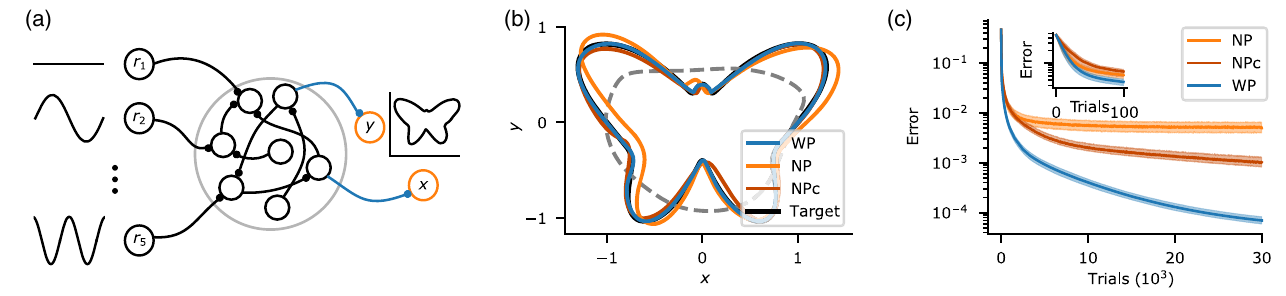
FIG. 7. WP outperforms NP on a reservoir computing-based drawing task. (a) Schematic of the recurrent, fixed reservoir receiving five external inputs. Only readout weights are learned. (b) Target (black) and final outputs of WP (blue), NP (orange), and NPc (red). A least squares fit (gray, dashed line) using only the first five principle components of the reservoir dynamics demonstrates that the task critically depends on reading out further, weaker dynamical components. (c) Error curves on a logarithmic scale. WP reaches a lower final error than NP and NPc, with NPc improving on NP; cf. also (b). Inset: early error evolution. There is a considerable improvement already during the first 50 trials. The curves show median (solid) and interquartile range between first and third quartile (shaded) over 1000 runs of the same network with different noise